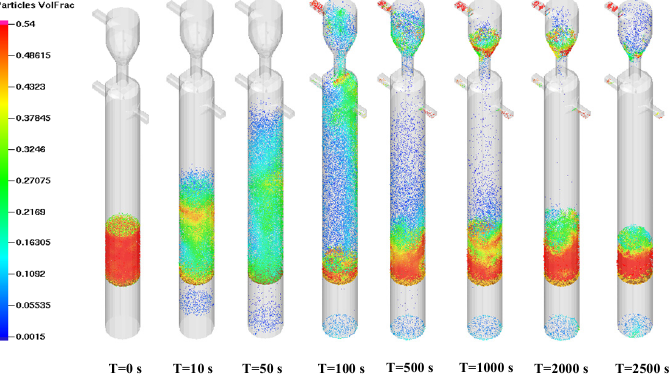
Figure 5. The initial fluidization process of simulated bed.